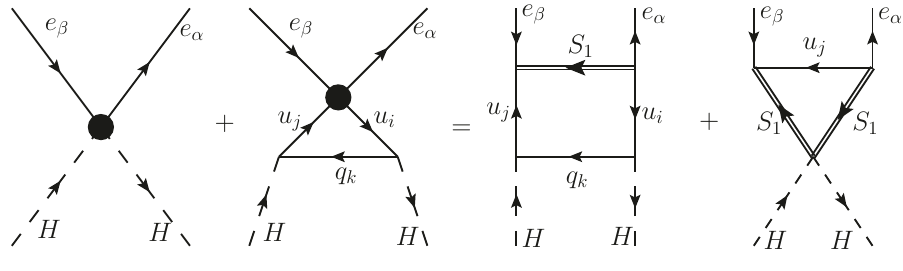
Figure 1 . Diagrams for the matching of the h (cid:22) eeH y H i Green